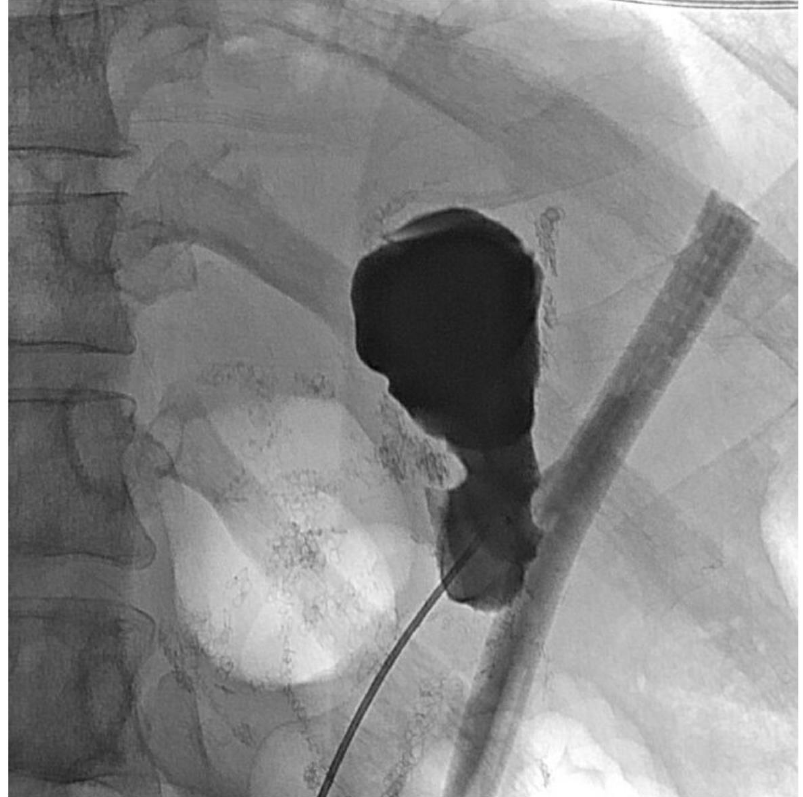
Figure 9. Needle access into orphaned stomach segment.